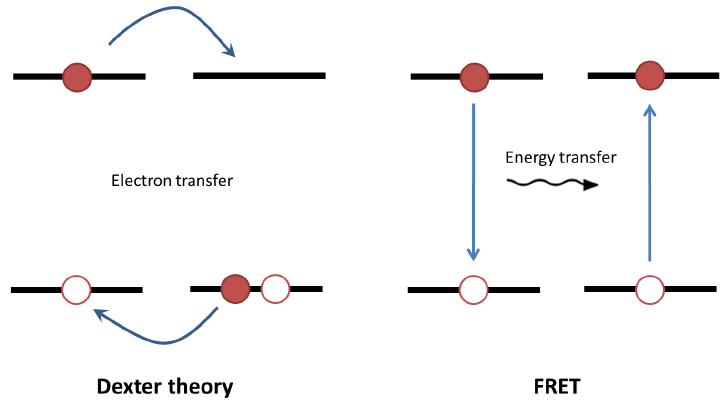
Figure 5. Left : exciton transport through charge transfer. Right : exciton transport through energy